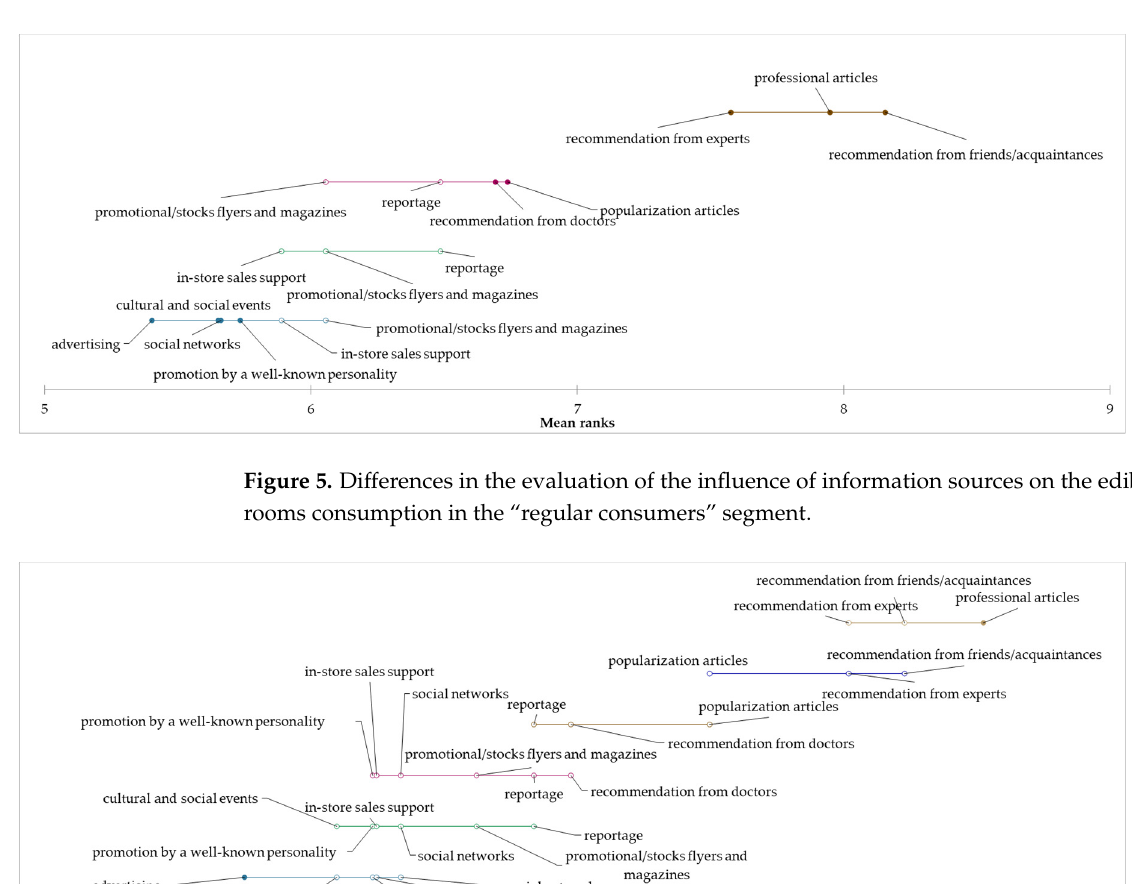
Figure 4. Differences in the evaluation of the influence of information sources on the edible mush- rooms consumption in the “occasional consumers” segment.